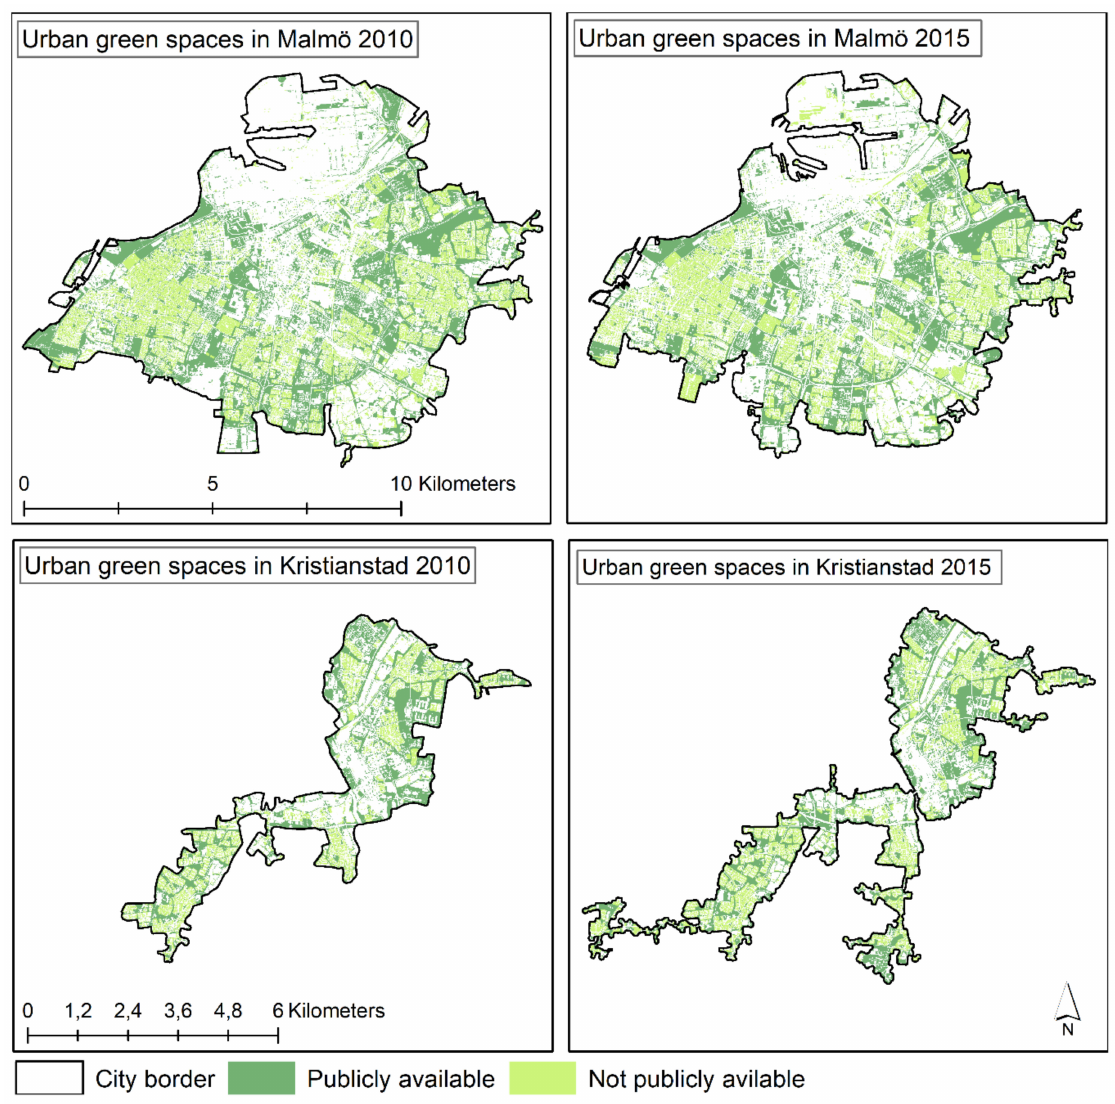
Figure 3. Map showing distribution of total and publicly available urban green spaces Malmö and Kristianstad city, within respectively municipality in 2010 and